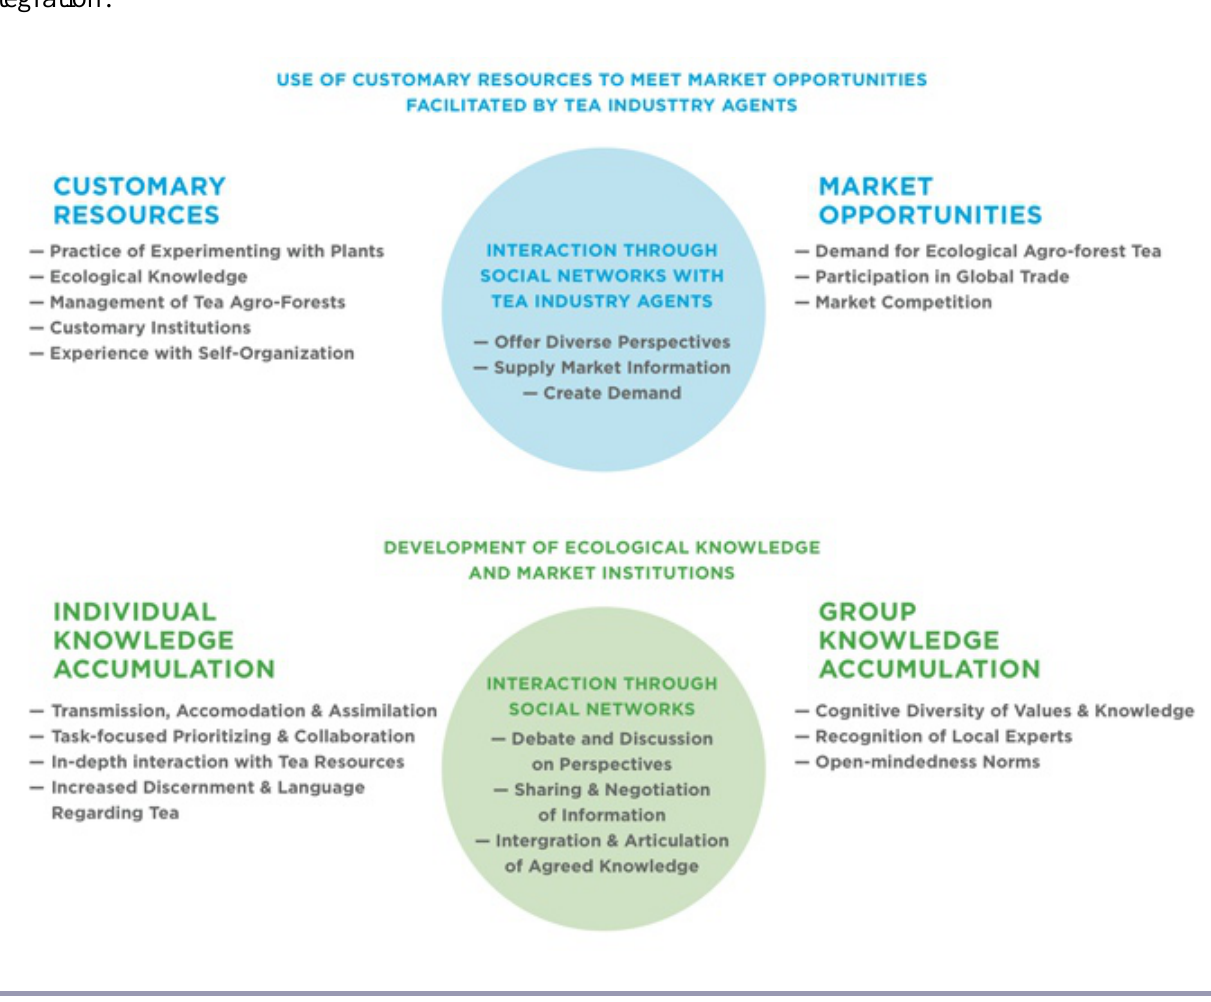
Fig. 4 . The process of ecological knowledge development of tea resources in response increased market